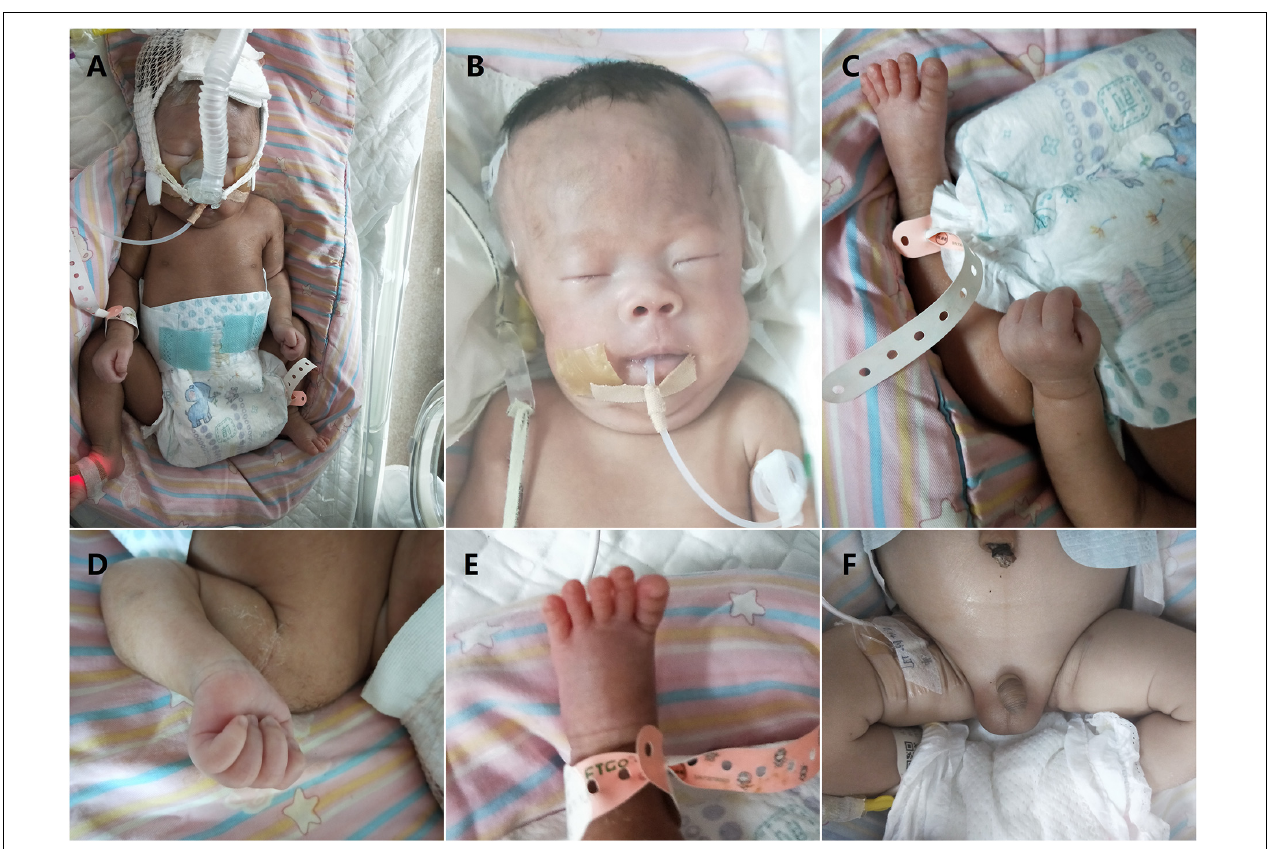
FIGURE 1 | Clinical features of our patient with Prader–Willi syndrome (PWS) (2 days after birth). (A) Non-invasive respiratory support with positive end expiratory pressure was used for the treatment of respiratory distress. Overall appearance of the boy indicated no significant difference between the patient and normal infants. Note muscular hypotonia and abnormal position of the hands and feet. (B) Facial features of the boy (narrow forehead, fair eyebrow, bilateral epicanthus, flat nose, big nostrils, and thin upper lip). (C) Overall appearance of abnormal position of the hands and feet. (D) Abnormal position of the fingers with thumbs adducted under index and middle fingers, flexed hands and wrists, persistently clenched hands and arachnodactyly. (E) Small feet and toes. (F) Genital hypoplasia with slight maldescent of the left testis.